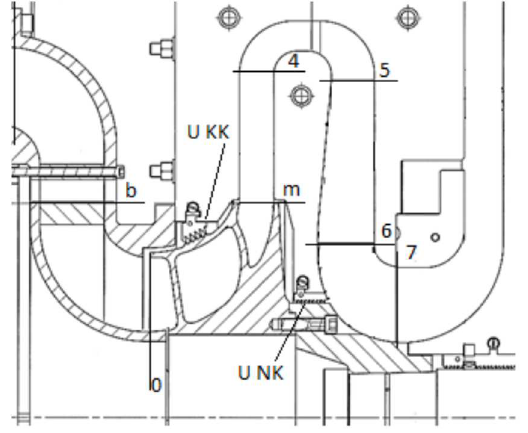
Fig. 2. The cross-section of the compressor with evaluated planes .